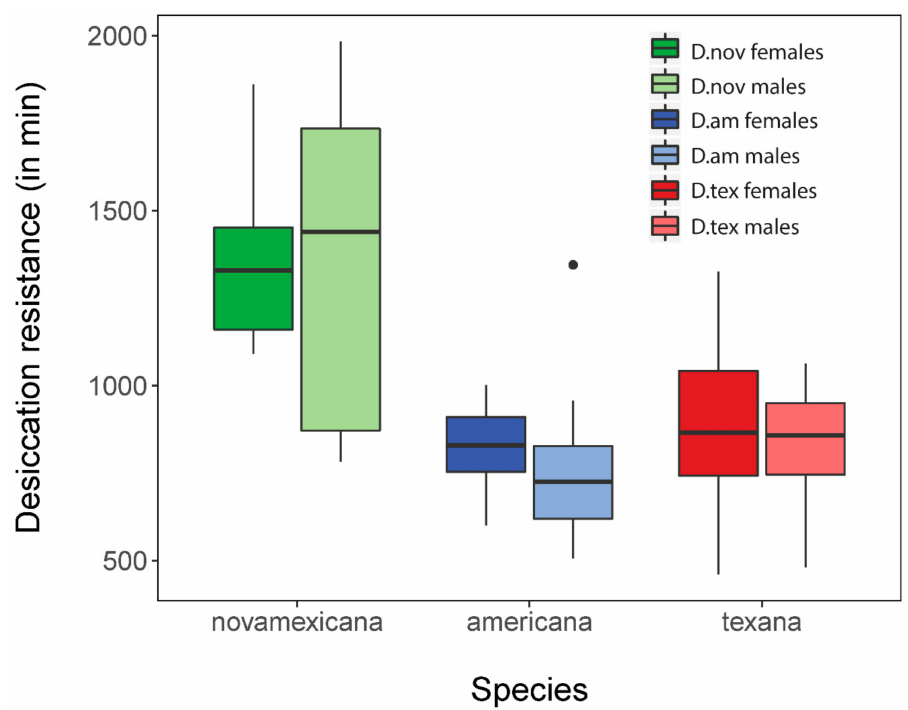
Figure 1. Variation in desiccation resistance between species and sexes, in minutes survived under acute desiccation ( n = 5 for all identities) (means = black bars; quartiles = boxes). Original data is from Davis and Moyle 2019 [26]. ANOVA shows that species (F(2) = 10.16; p = 0.00027) but not sexes (F(1) = 0.66; p = 0.42) significantly di ff er in desiccation resistance.